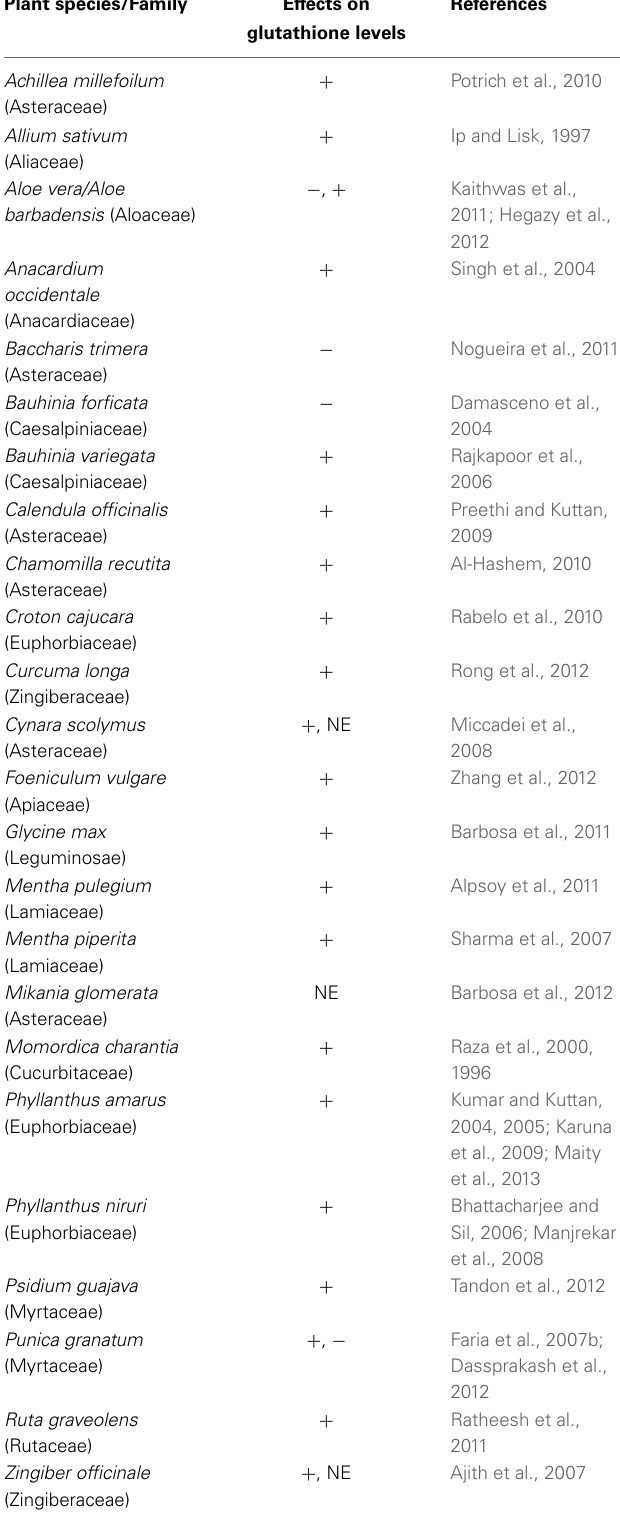
Table 7 | Medicinal plant species listed in RENISUS with reported effects of on glutathione